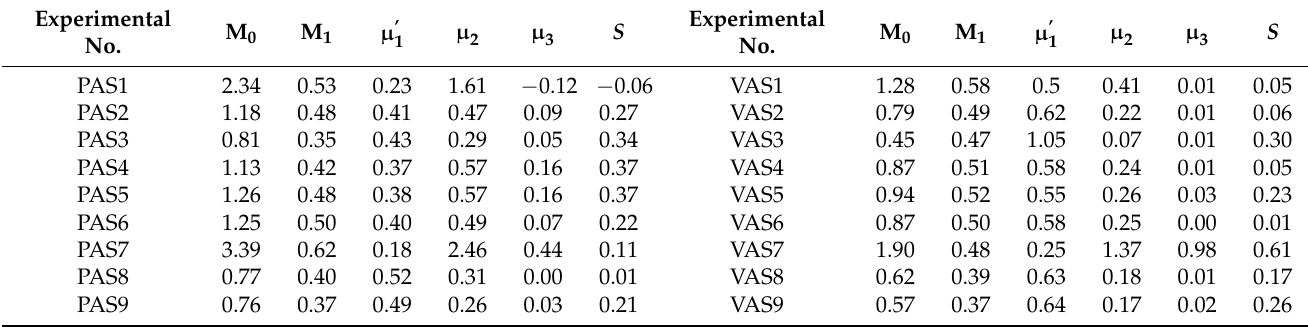
Table 3. Summary of solute breakthrough curve characteristics.